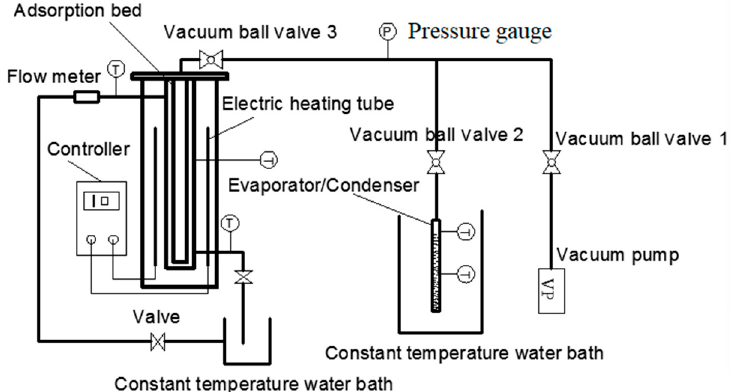
Figure 19. Schematic diagram of adsorption performance test.